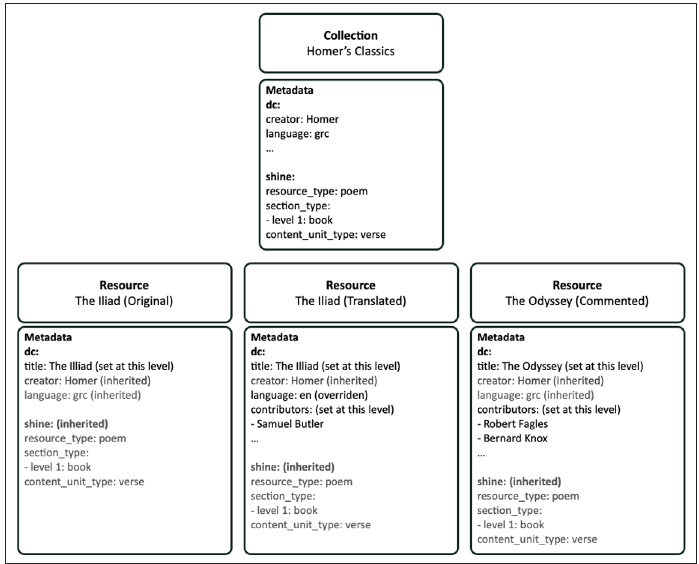
Figure 3: Representing a Homer’s classics collection and its resources using